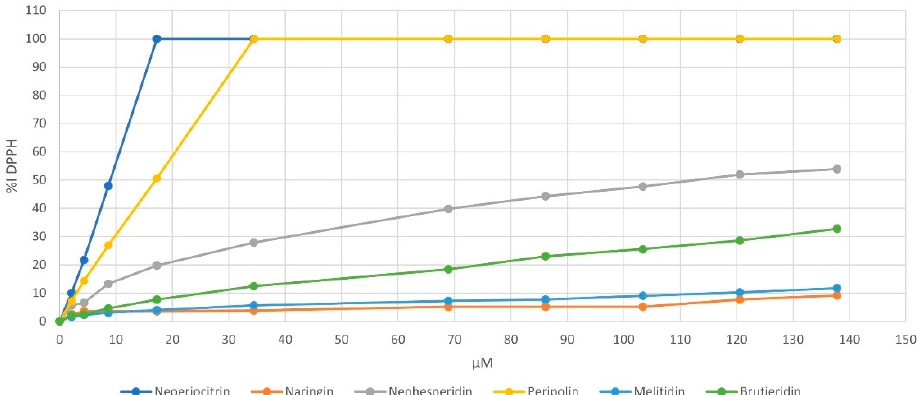
Figure 3. Inhibition of DPPH (%) versus flavonoids concentration.